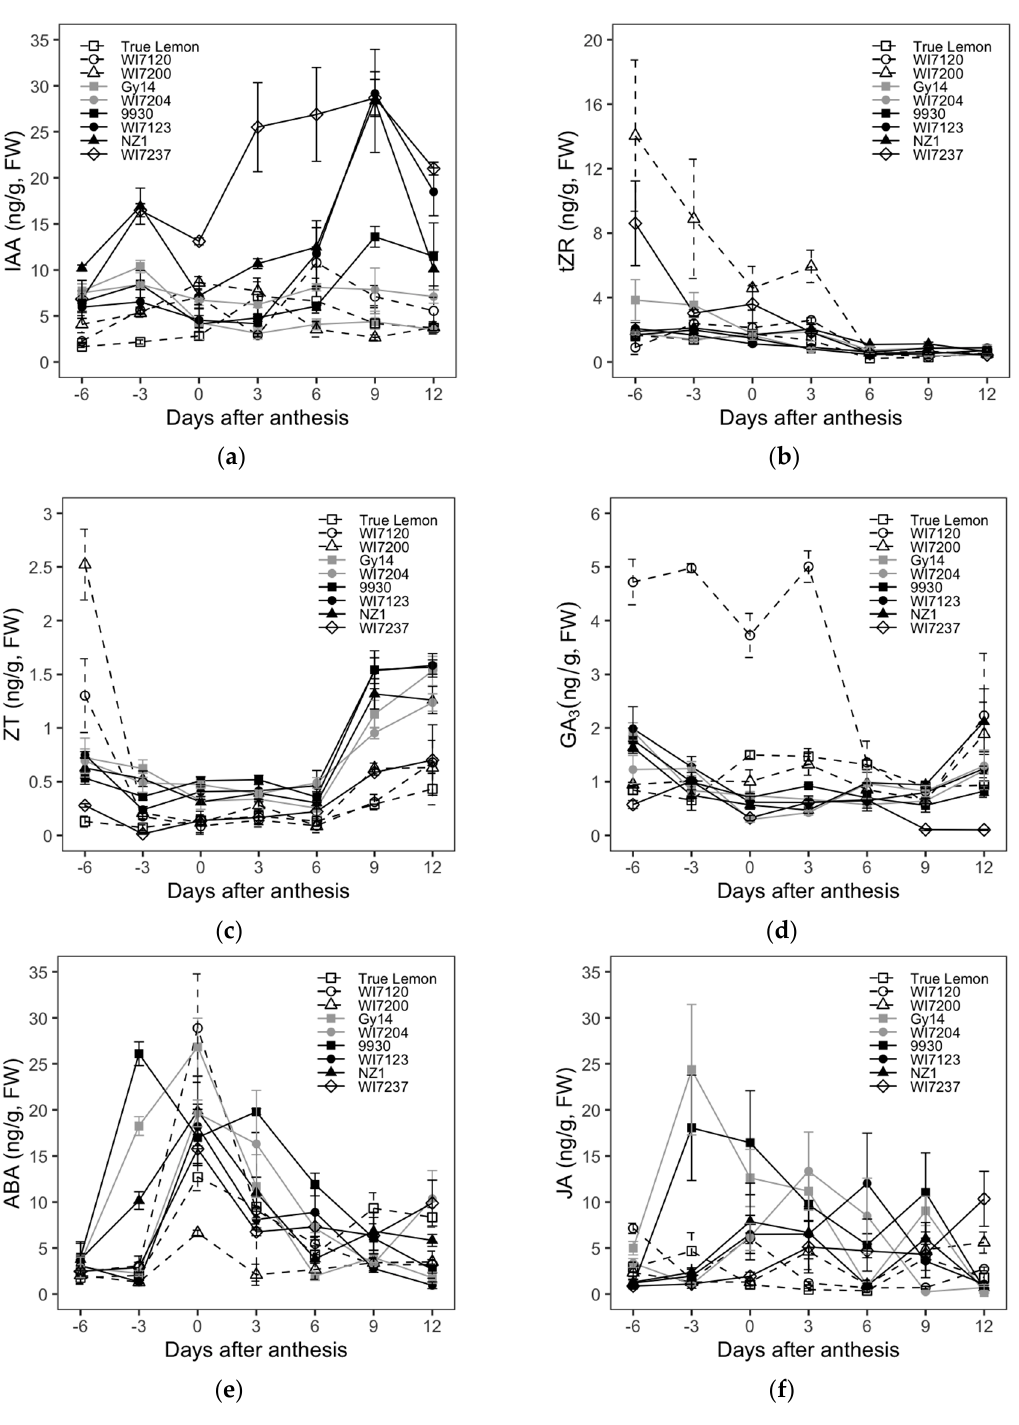
Figure 3. Comparative analysis of the endogenous hormone changes for the nine cucumber inbred lines at different fruit development stages. ( a )–( f ) Changes in the indole-3-acetic acid (IAA), trans-zeatin riboside (tZR), zeatin (ZT), gibberellic acid (GA 3 ), abscisic acid (ABA) and jasmonic acid (JA) content. Each value is the mean ± SE of 3 fruits. FW, fresh weight.